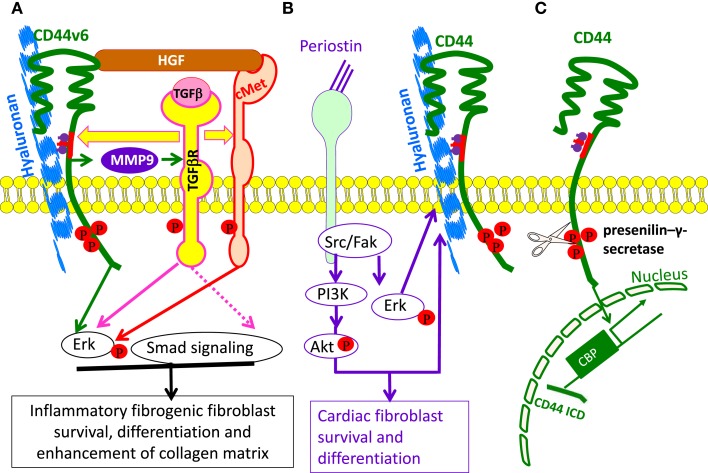
The involvement of HA and CD44 in cell survival and differentiation. (A) Model for the involvement of CD44v6 and Met due to autocrine TGF β1 signaling in lung fibrogenic fibroblasts. The repetitive lung injury in pulmonary fibrosis results in overexpression of TGFβ1 and TGFβ1-induced autocrine signaling that induces a sustained expression of CD44v6 and its co-receptor c-Met. This activates fibrogenic lung fibroblasts with subsequent increased collagen matrix synthesis. Therefore, TGF β1-induced CD44v6 and Met can have a crucial role for the sustained fibrogenic activation of lung fibroblasts. The CD44-phosphorylated ERM complex initiates activation of transforming growth factor-β receptor 1 and 2 (TGFβRI and II) and the downstream SMAD signaling complex, which contribute to fibrosis. (B) Model for involvement of periostin in HA-CD44-mediated cell survival and differentiation. Matricellular protein [periostin (PN)] binding to β1 or β3-integrin activates FAK, which activates downstream MAPK/Erk and PI3K/Akt to regulate cardiac valve cell growth, survival, differentiation into fibroblasts, and matrix organization (maturation). PN binding to β3-integrin also activates Has2 mRNA expression, Has2 phosphorylation, and HA synthesis. The interaction of HA with CD44, may, in turn, amplify the downstream effects of PN on heart valve cushion cell differentiation/maturation processes. (C) Cleavage of the extracellular domain is accompanied by the cleavage of the intracellular domain (ICD) by the presenilin-γ-secretase complex. The CD44 ICD acts together with CBP or p300 as a transcription factor and promotes CD44 transcription and extracellular matrix production.